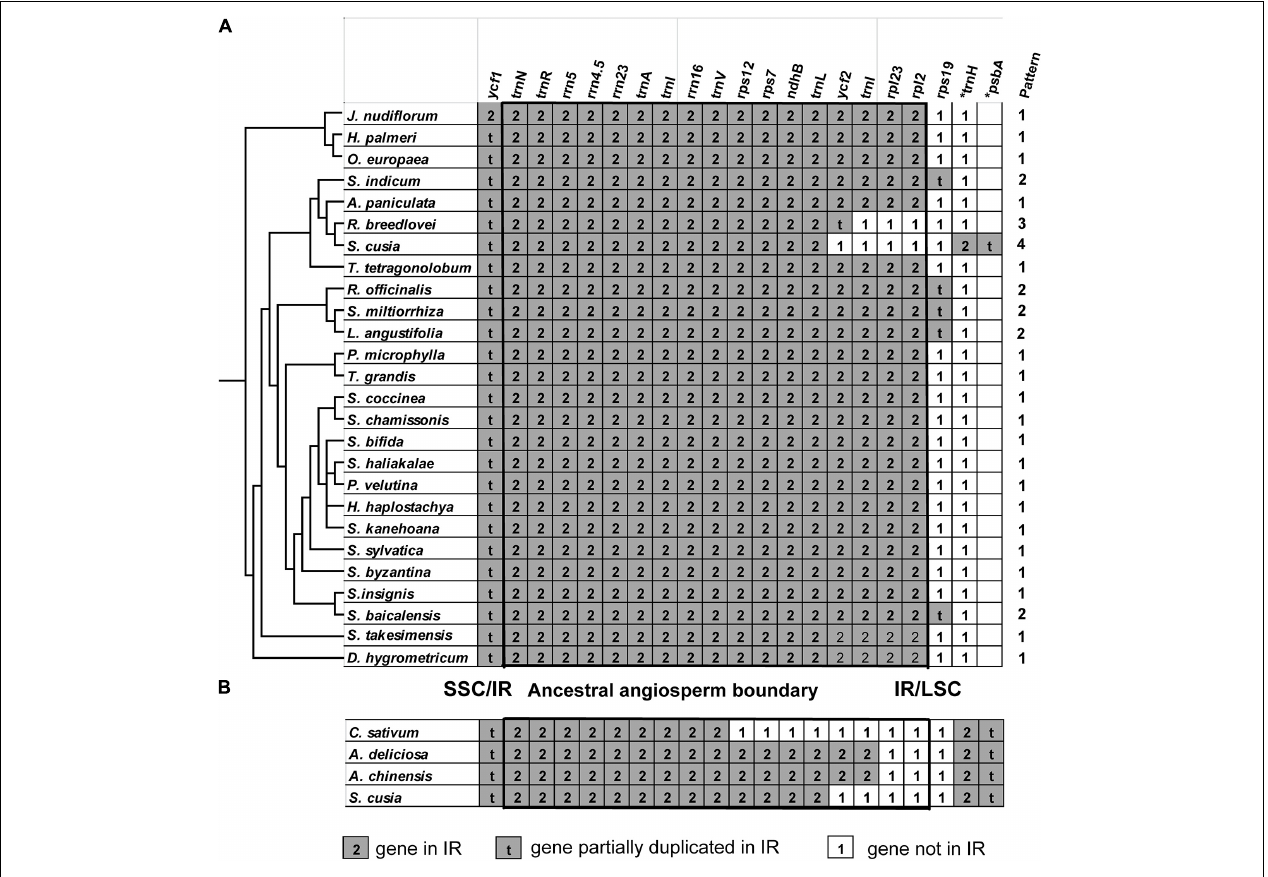
FIGURE 5 | Comparison of IR contents (A) between S. cusia and several representative cp genomes from Lamiales and (B) between S. cusia and three non-Lamiales cp genomes. The ancestral angiosperm IR regions are shown in